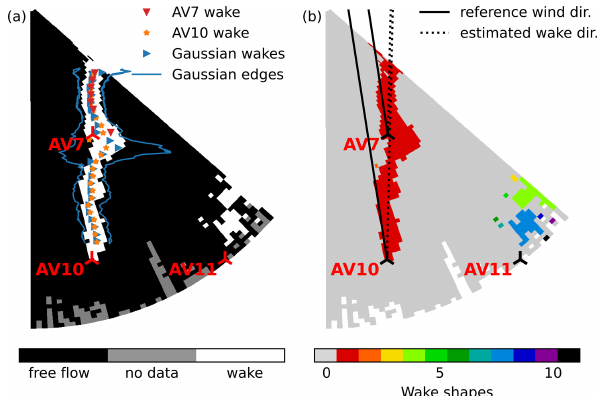
Figure 21. Scan 222 (aligned-wake subset) sample wake identifi- cation and characterization showing (a) comparison of the ATS and Gaussian methods, (b) wakes identified by the ATS method after the threshold is applied, and wind and wake direction.